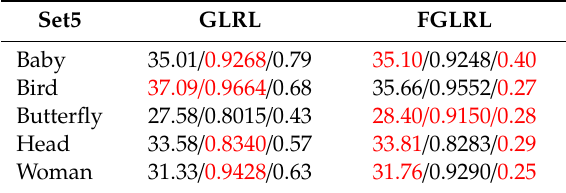
Comment: Red color indicates the best performance of two